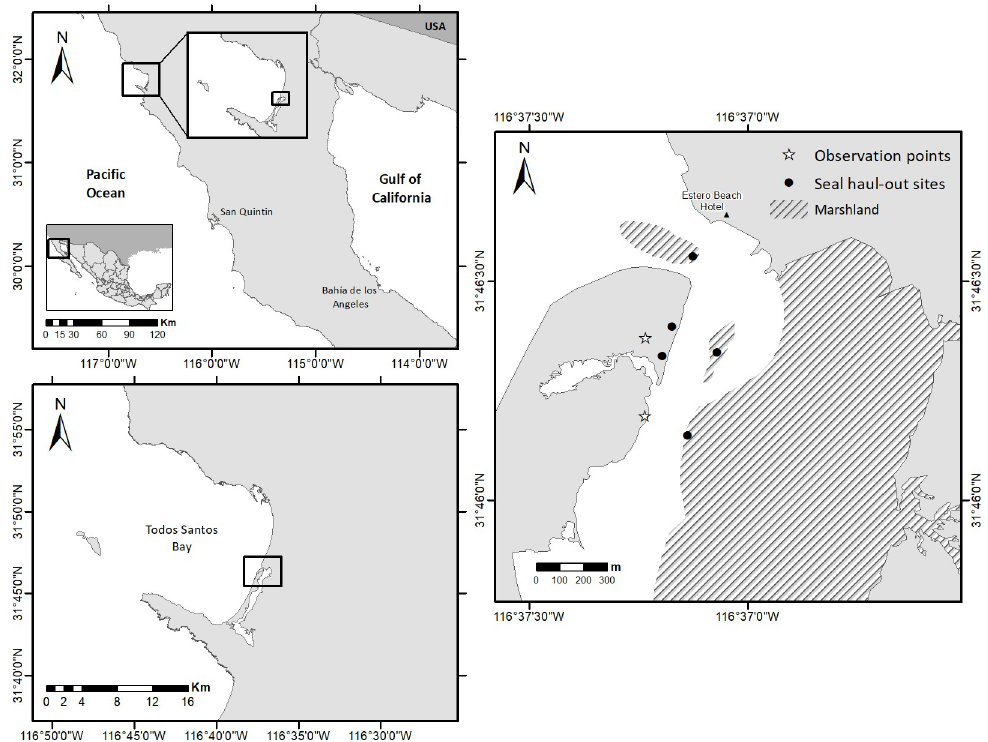
Fig 1. Location of study site: Punta Banda Estuary (PBE), Baja California, Mexico. Basemap source: CONABIO ( Comisión Nacional para el Conocimiento y Uso de la Biodiversidad , National Commission on Biodiversity Knowledge and Use), División política estatal 1 : 250 , 000 (State political division 1:250,000), http://www.conabio.gob.mx/informacion/ metadata/gis/dest_2015gw.xml?_httpcache=yes&_xsl=/db/metadata/xsl/fgdc_html.xsl&_indent=no.